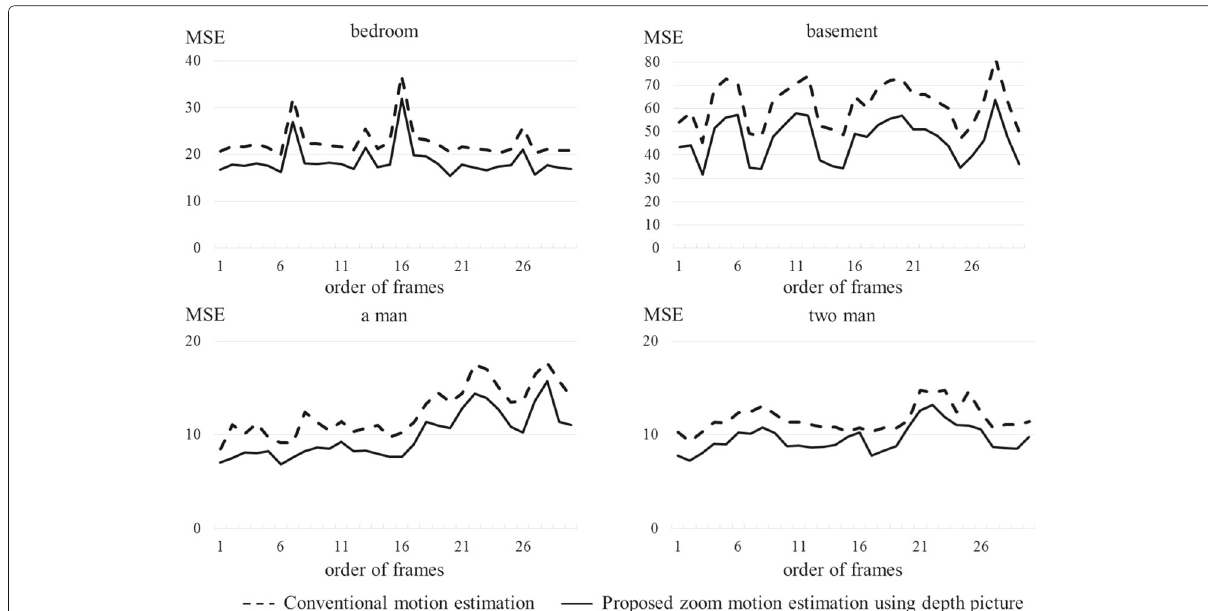
Fig. 12 Comparison of MSEs between conventional and proposed methods for color videos (16 × 16 block